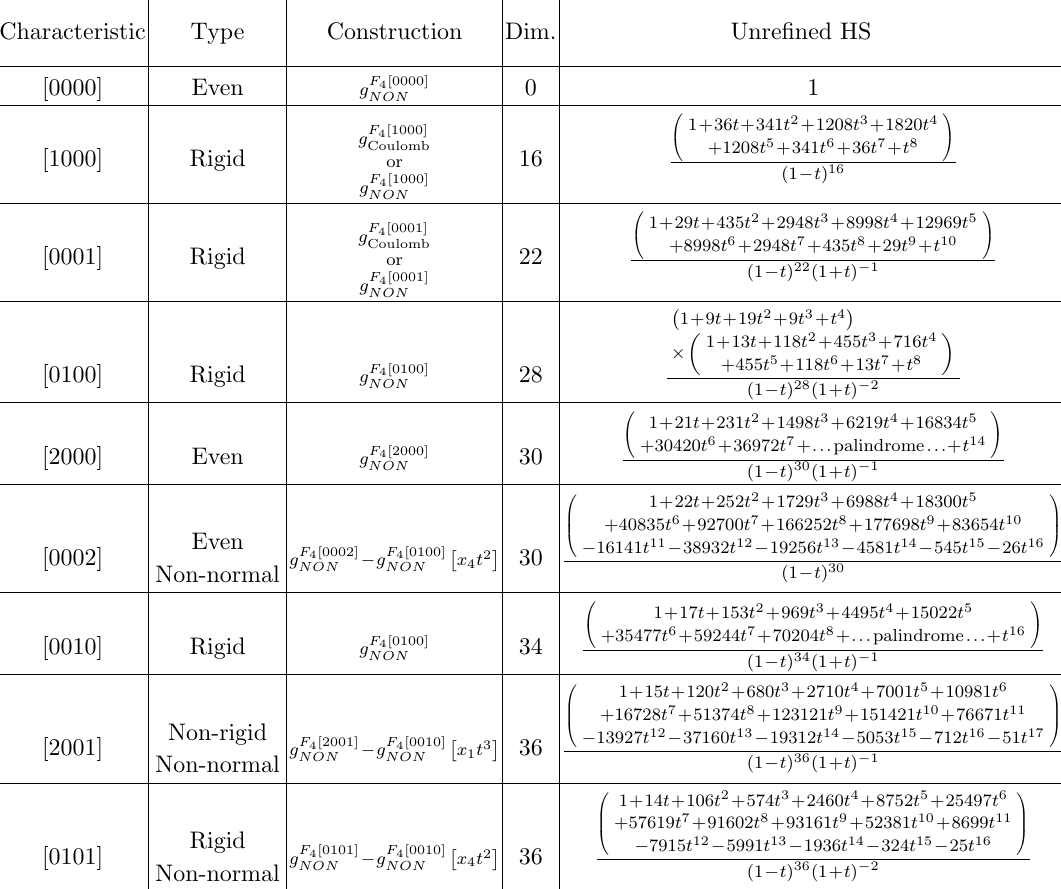
Table 6 . F 4 orbit constructions and Hilbert series